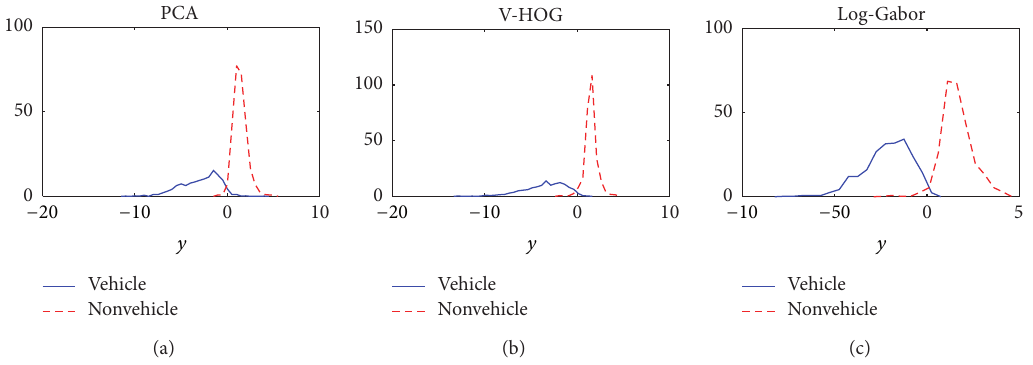
Figure 5: Distribution of soft output delivered by SVM for PCA, V-HOG, and log-Gabor based